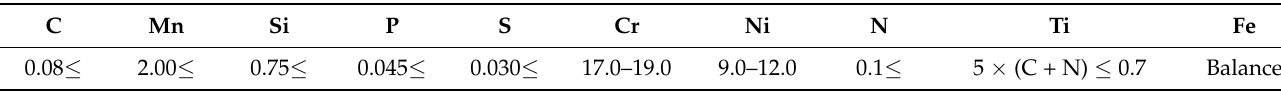
Table 2. Chemical composition (% wt.) of SS321